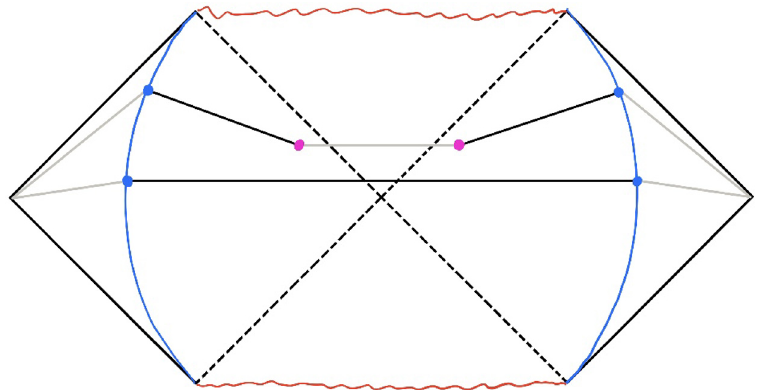
Figure 3 . A Penrose diagram of an eternal black hole. A pair of timelike anchor curves (blue curves) separates the spacetime into an interior and two exteriors. The two spatial hypersurfaces intersect the anchor curves at different times. On the late time surface the generalized entropy is dominated by the area term associated to the islands denoted by purple